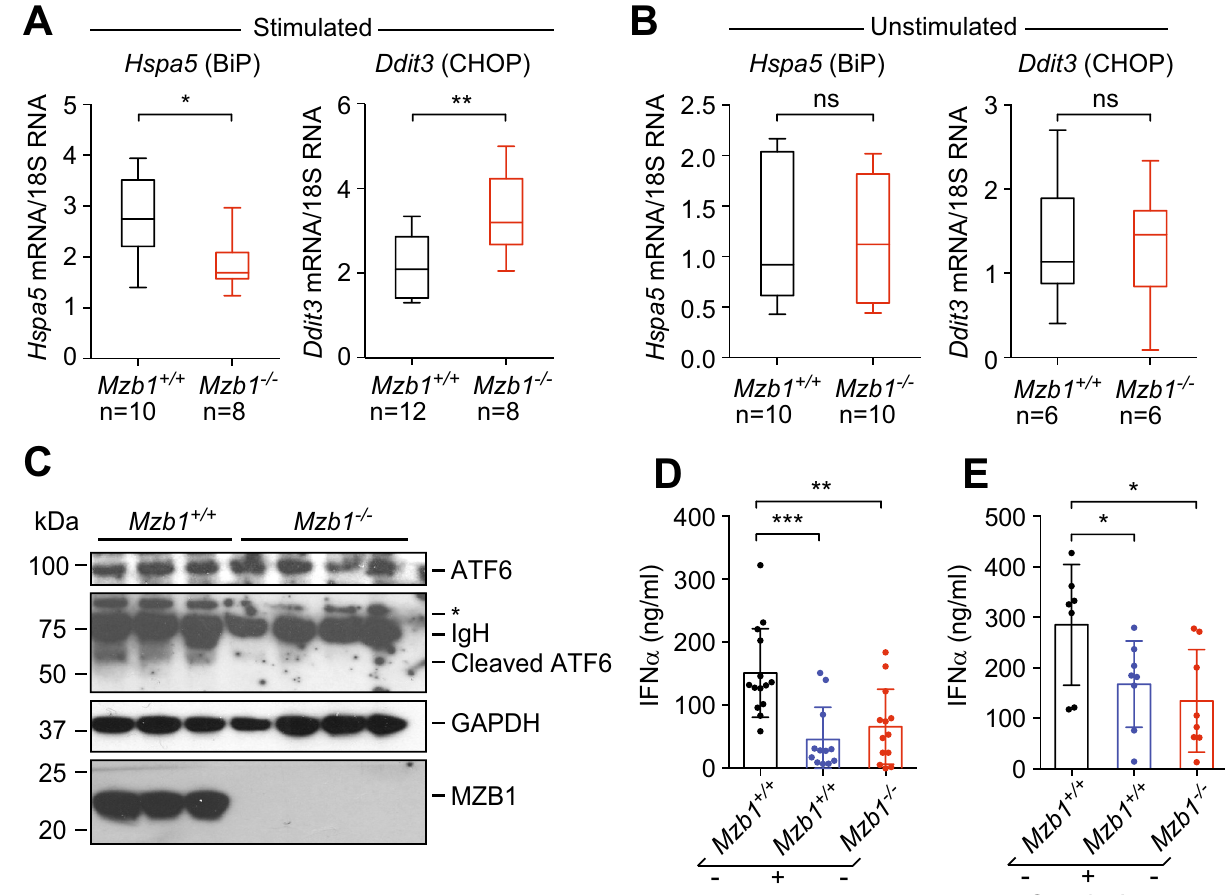
Figure 3. Mzb1 −/− pDCs exhibit an improper ER stress response due to the impaired activation of the ATF6 pathway. ( A ) Box plot of qRT-PCR analysis to determine the relative Hspa5 (BiP) and Ddit3 (CHOP) mRNA levels after stimulation of Mzb1 + / + and Mzb1 −/− pDCs with CpG A for 24 h. mRNA levels were normalized to those of 18S rRNA. Numbers of independent samples (n) are indicated below the graph. ( B ) qRT-PCR analysis of Hspa5 (BiP) and Ddit3 (CHOP) mRNA at basal levels in unstimulated pDCs. ( C ) Immunoblot analysis to detect uncleaved and cleaved ATF6 (approx. 55 kDa) in CpG A-stimulated pDCs. GAPDH serves as a loading control. IgH indicates residual IgH from the serum and * indicates an unknown cross-reacting protein. Uncropped blots are shown in Supplementary Fig. S3D. ( D ) ELISA-based quantification of the secreted IFNα in the supernatant of 10 5 Mzb1 + / + and Mzb1 −/− pDCs that were untreated or treated with the ATF6 inhibitor AEBSF at 100 µM. ( E ) ELISA-based quantification of secreted IFNα in the supernatant of Mzb1 + / + and Mzb1 −/− pDCs, untreated or treated with the ATF6 inhibitor Ceapin A7 at 3 µM. Each dot represents an individual pDC culture derived from an individual mouse. Statistical difference between the mean was analyzed by an unpaired two-tailed Student’s t-test. *P ≤ 0.05; **P ≤ 0.005. Error bars show SD. ns,